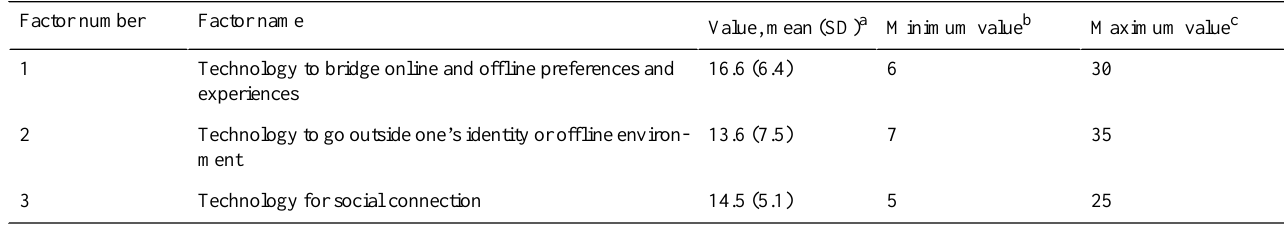
Table 2. The Adolescents’Digital Technology Interactions and Importance scale: descriptive information for 3-factor structure